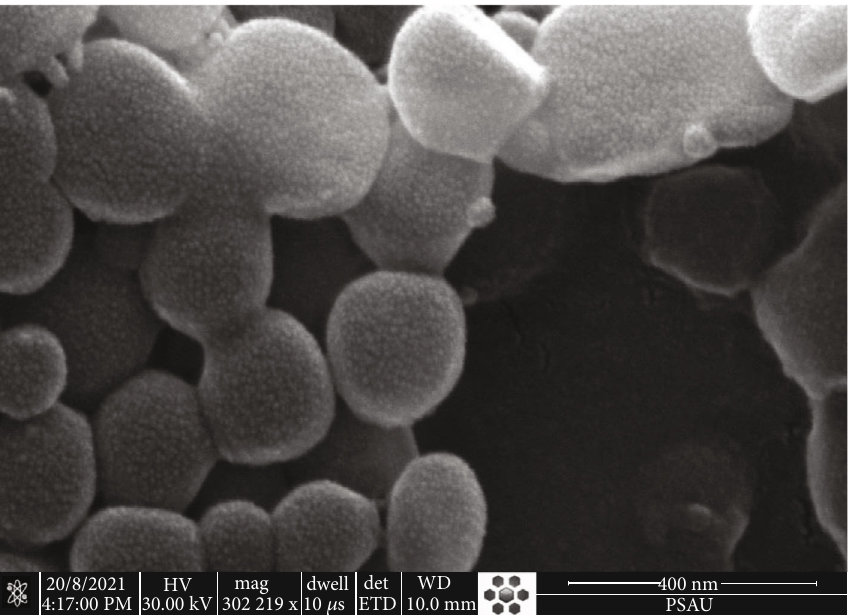
Figure 4: SEM images of the optimized nanosponge